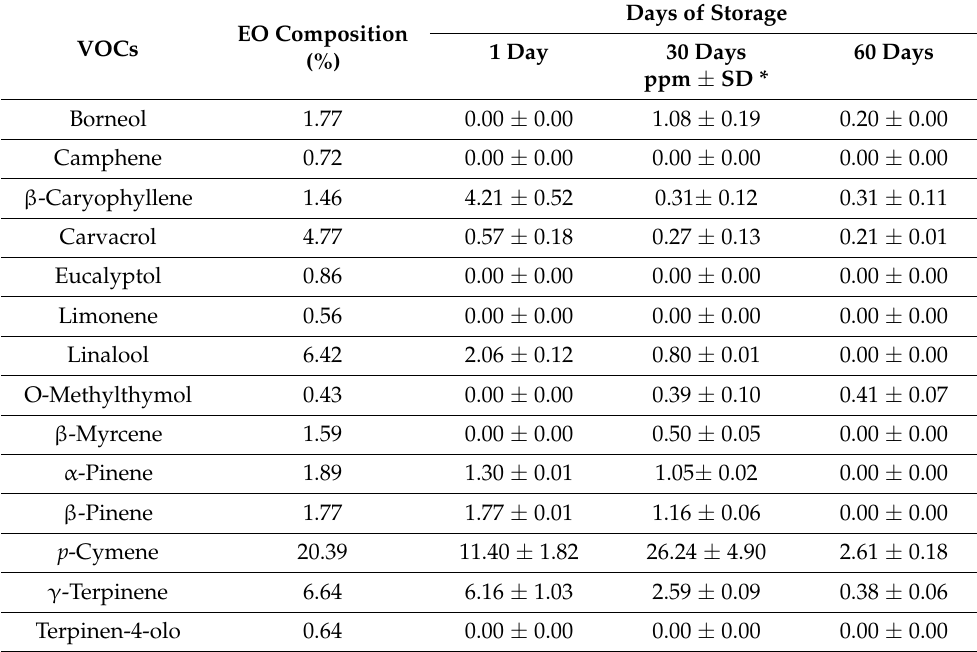
Table 4. Composition of thyme essential oil and characterization of the atmosphere of cabinet during the storage trial on apples ‘Opal’ obtained by GC-MS and SPME-GC-MS analysis, respectively. Air in the cabinet was sampled at 1, 30, and 60 days of